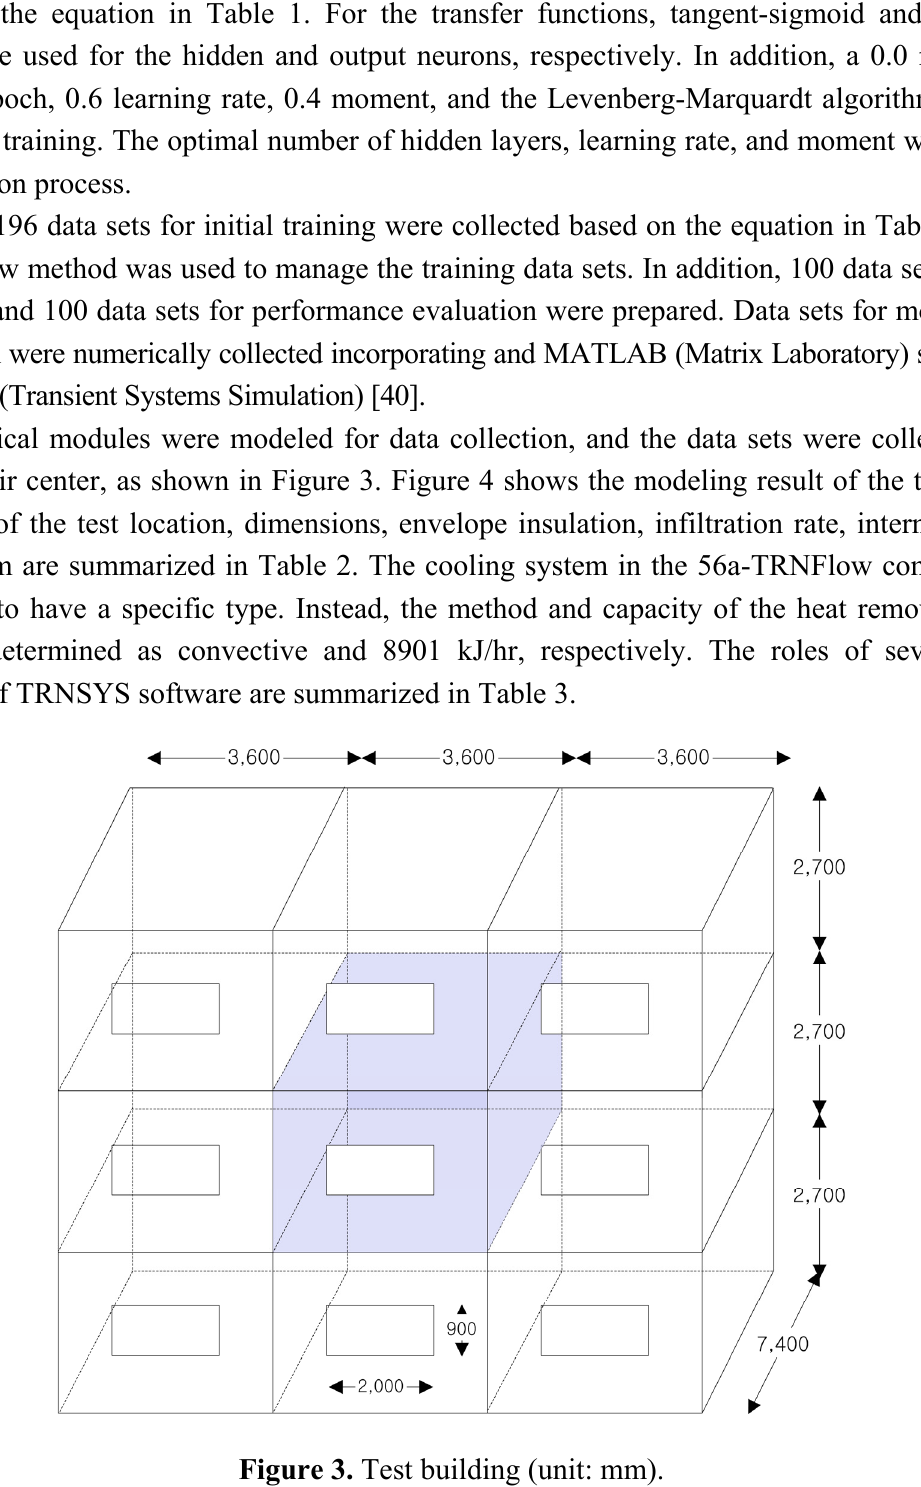
Figure 3. Test building (unit: